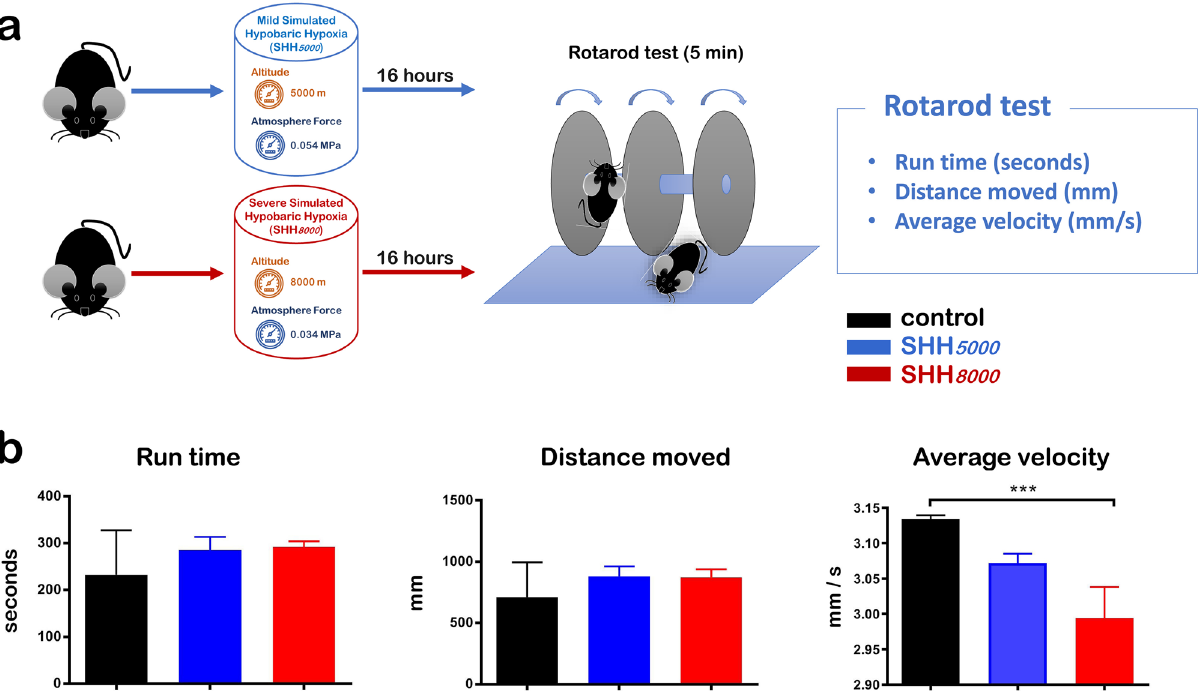
Figure 2. Mice presented an improved balance ability under SHH conditions. ( a ) Scheme of the rotarod test after 16 h of SHH 5000 or SHH 8000 treatment aiming to examine the balance ability of mice. ( b ) Run time, distance and average speed after SHH 5000 and SHH 8000 treatment. Each value is expressed as the mean ± standard error of the mean. Multiple comparisons between groups were carried out with Tukey’s post hoc test. *P value < 0.05; **P value < 0.01; ***P value < 0.001, n = 5 per